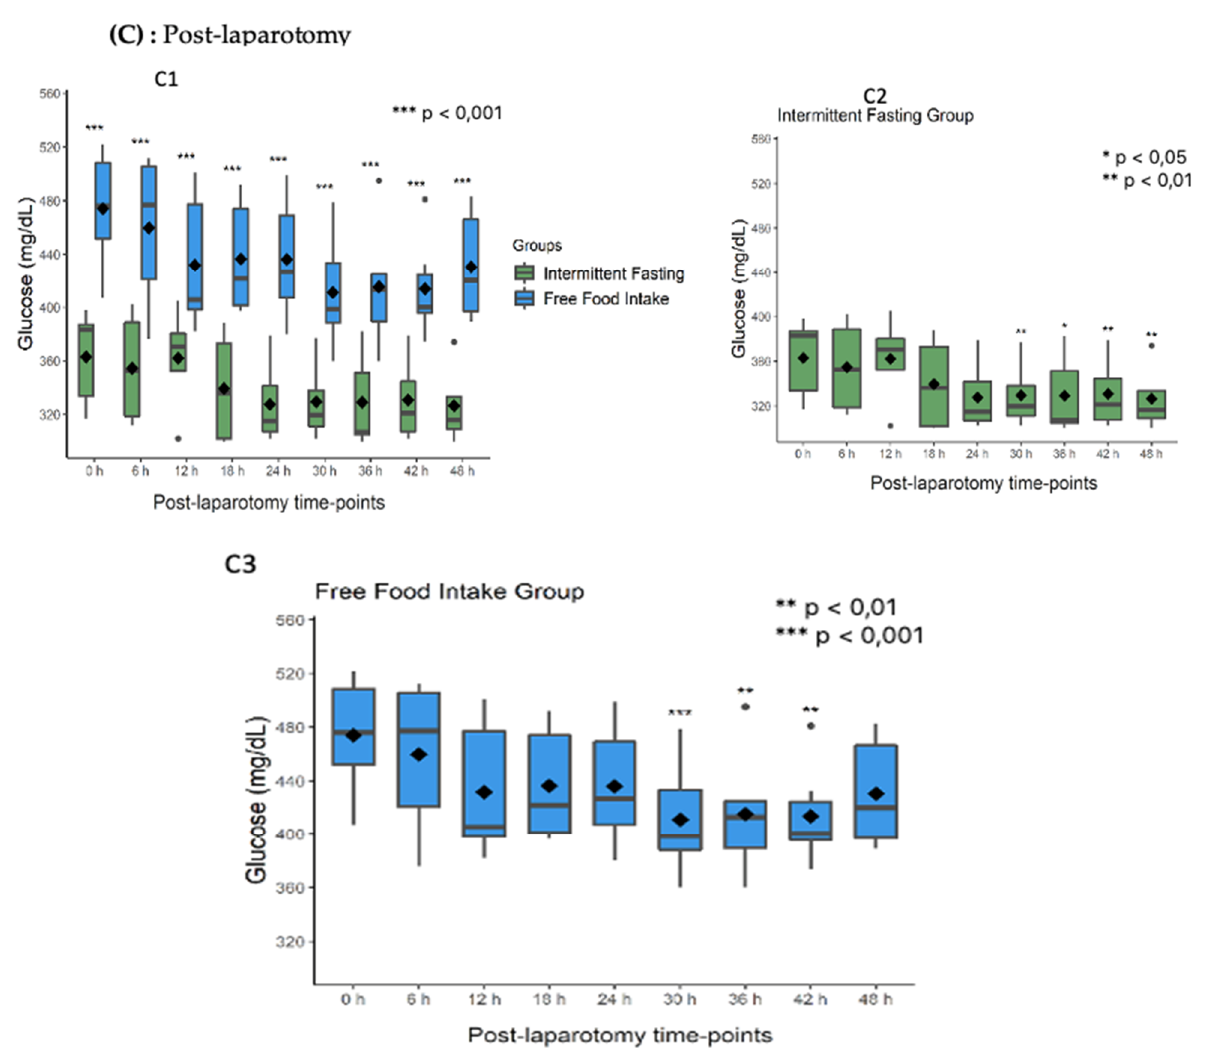
Figure 2. Green represents IF group. Blue represents FF group. * p < 0.05 ** p < 0.01 *** p < 0.001. The lower and upper bounds of the box represent the first and third quartiles of the data, respectively; the horizontal line plus space inside the box indicates the median; the diamond indicates the mean; black circles indicate outliers; comparisons were performed by mixed linear models. ( A ) Pre-laparotomy fasting protocol glucose levels showing comparison between groups ( A1 ) and comparison over time in relation to the first time-point for only intermittent fasting group ( A2 ) and free food intake group ( A3 ). ( B ) Comparison of the weight and abdominal circumference between groups ( B1 / B2 ) and comparison over time in relation to the starting time-point for only intermittent fasting group ( B3/B4 ) and free food intake group ( B5 / B6 ). ( C ) Post-laparotomy fasting protocol glucose levels showing comparison between groups ( C1 ) and comparison over time in relation to the first time-point for only the intermittent fasting group ( C2 ) and free food intake group ( C3 ).